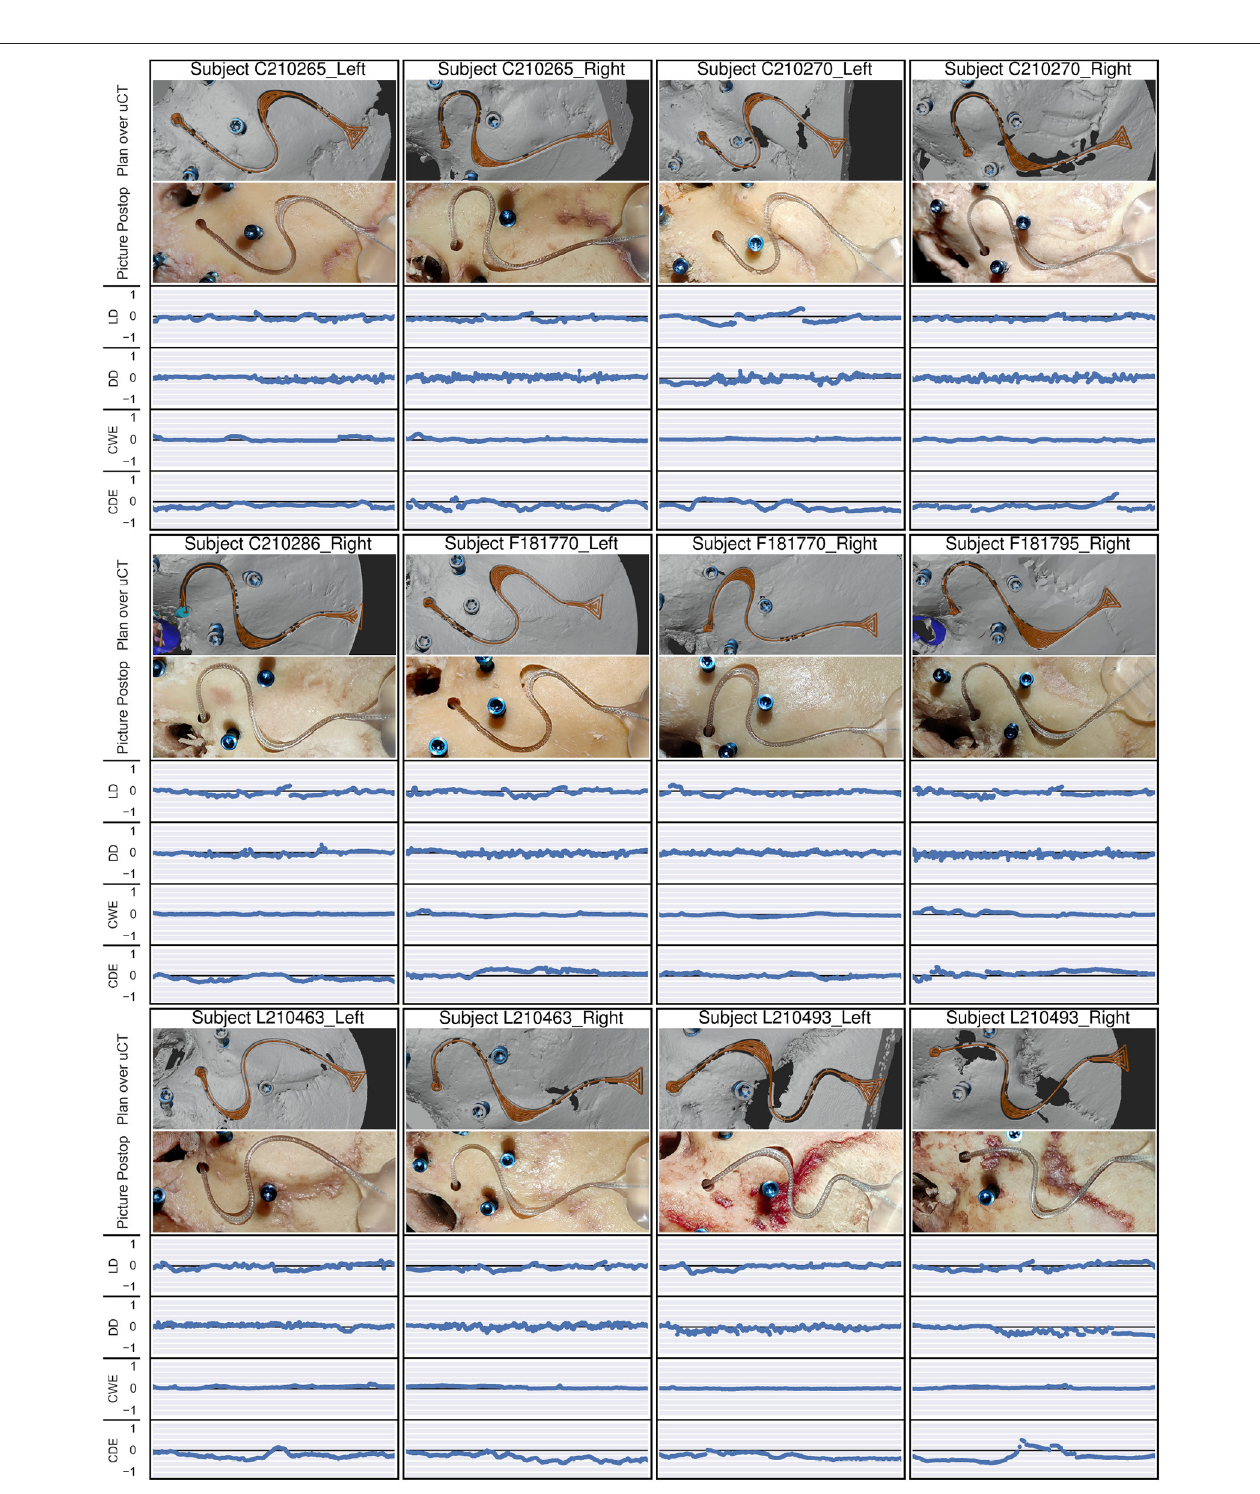
FIGURE 6 | For each subject, the top image depicts the planned path (orange) over the reconstructed temporal bone surface from the micro-CT (uCT) scan, containing the resulting electrode lead channel. The second image is a photo of the postoperative result after electrode insertion. The four following graphs show the lateral displacement (LD), the depth displacement (DD), the channel width error (CWE), and the channel depth error (CDE), all on a scale from − 1 to 1mm, which corresponds to the chosen safety margin. The safety margins were respected in all endpoints and cases.